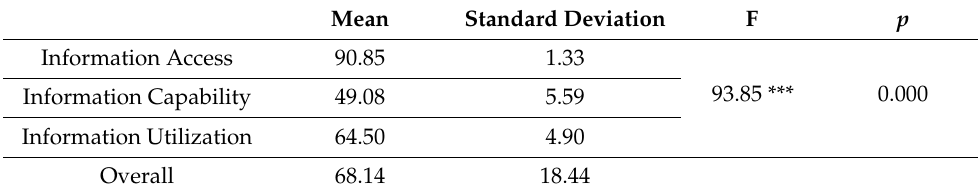
Table 7. Summary of Digital Information Level of Information